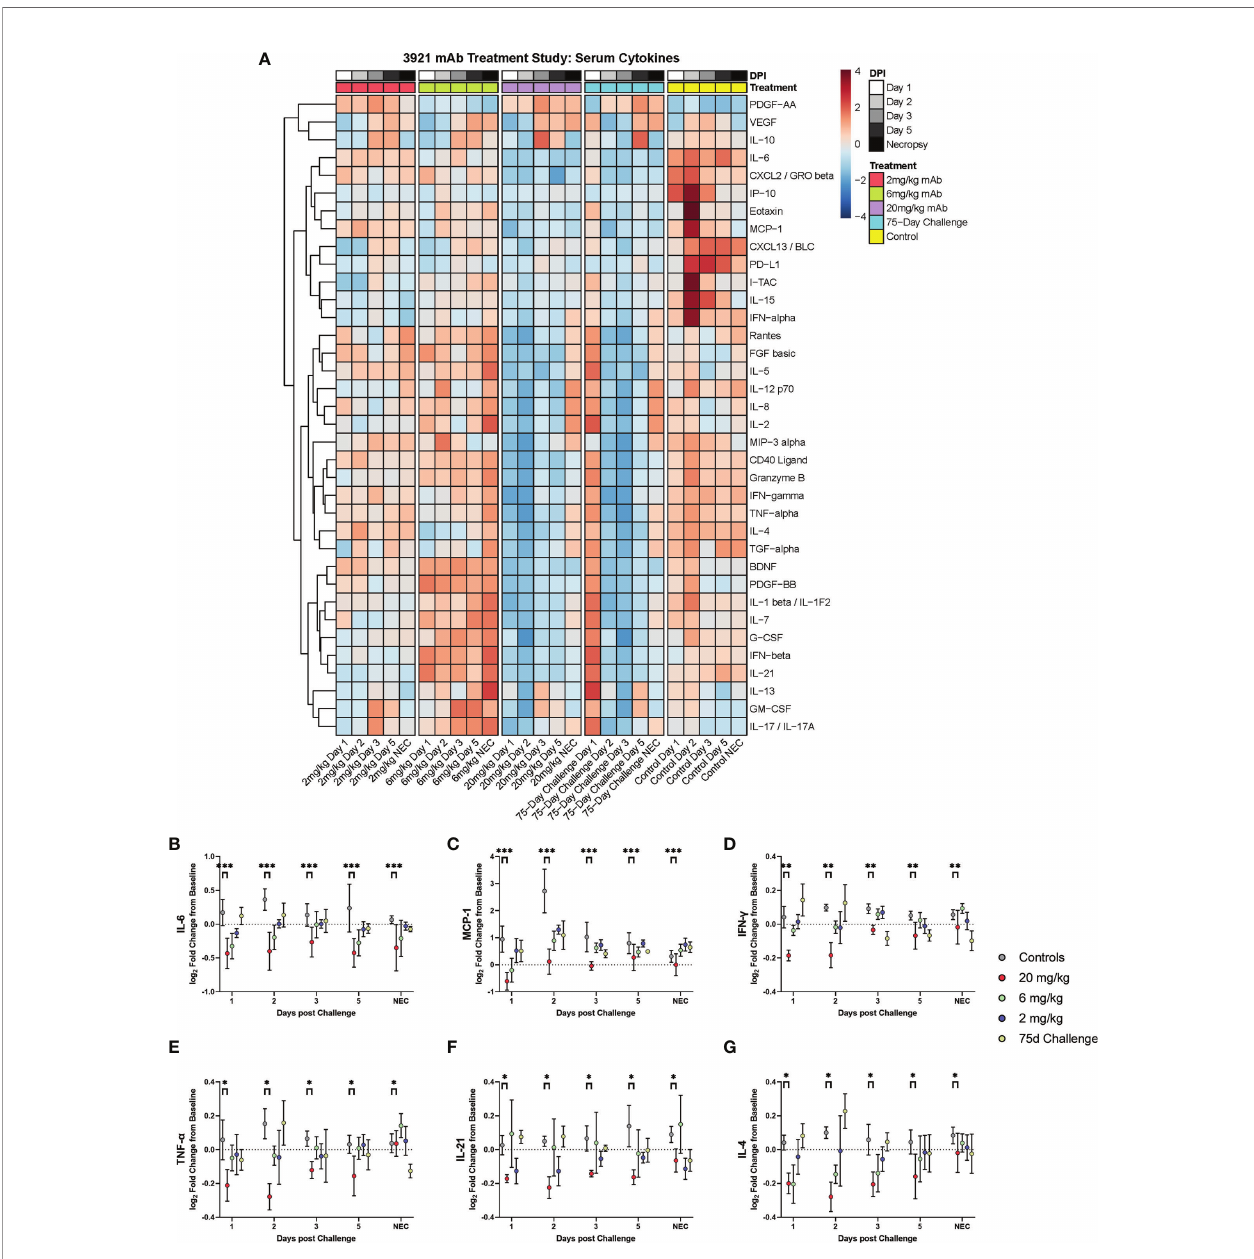
FIGURE 6 | Cytokine and Chemokine Expression During Challenge. Serum from peripheral blood draws were analyzed for cytokine/chemokine content and were assessed during challenge for the different dosage groups represented as (A) heat map of dosage groups vs . controls, and (B – G) log2 fold change between dosage groups, with comparisons made via two-way ANOVA with Tukey ’ s multiple comparisons test (*p < 0.05; **p < 0.01; ***p <